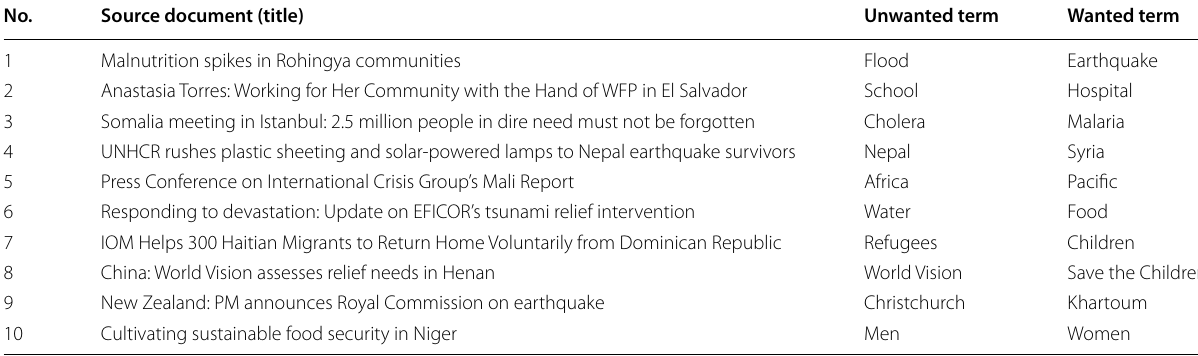
Table 2 Source documents used in document retrieval task No.